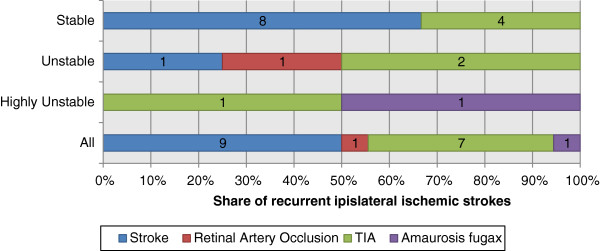
Type of presenting event among the patients with recurrent ipsilateral ischemic stroke within 7 days divided between clinically stable, unstable and highly unstable. Numbers inside bars denotes number of patients.